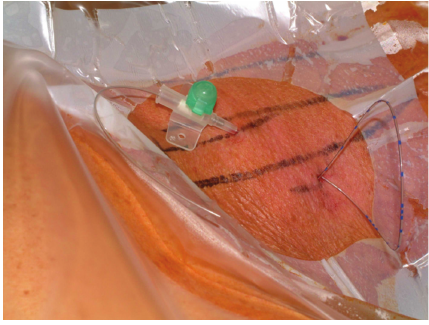
Figure 6: Catheter tunneling. Table 2: Suggested catheter insertions for di ff erent surgical